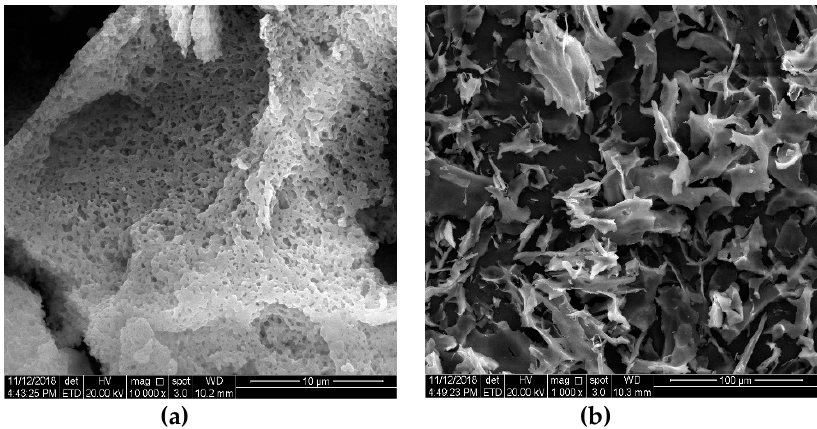
Figure 6. Photomicrographs of PCp-I ( a ) and PCp-II ( b ) as recorded by SEM.